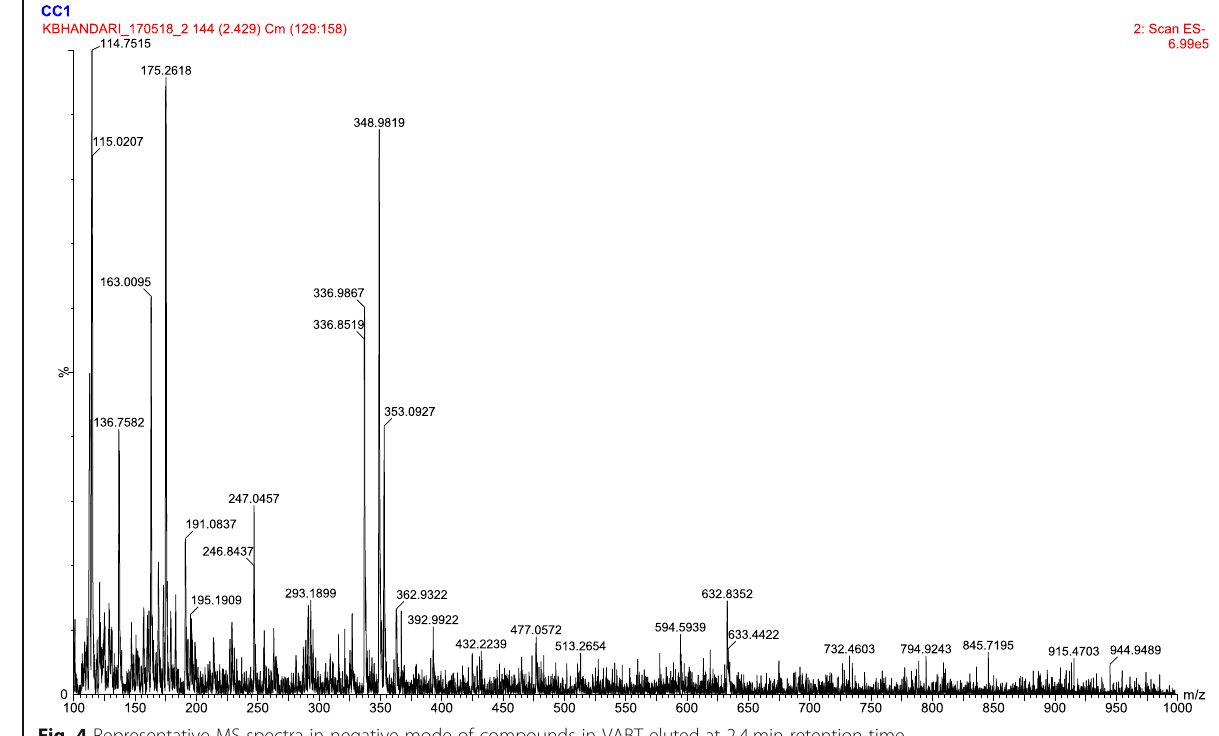
Fig. 4 Representative MS spectra in negative mode of compounds in VABT eluted at 2.4 min retention time